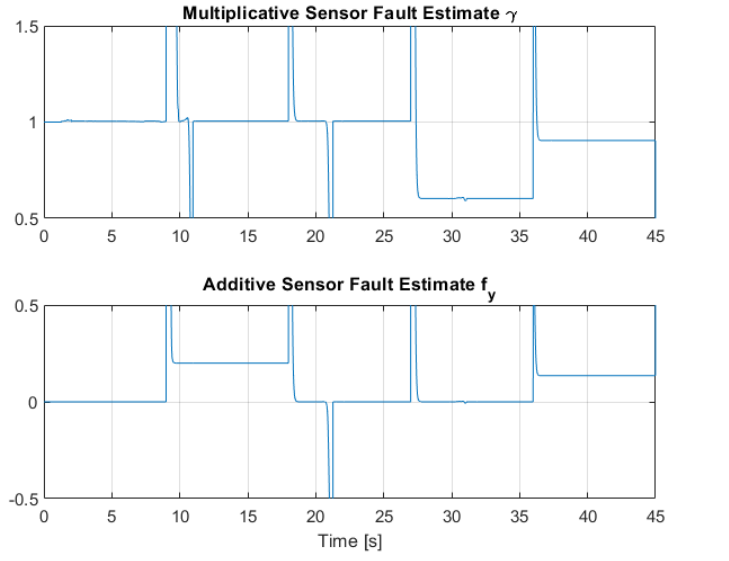
Figure 22. Multiplicative and additive sensor fault estimation by means of RLS for Link